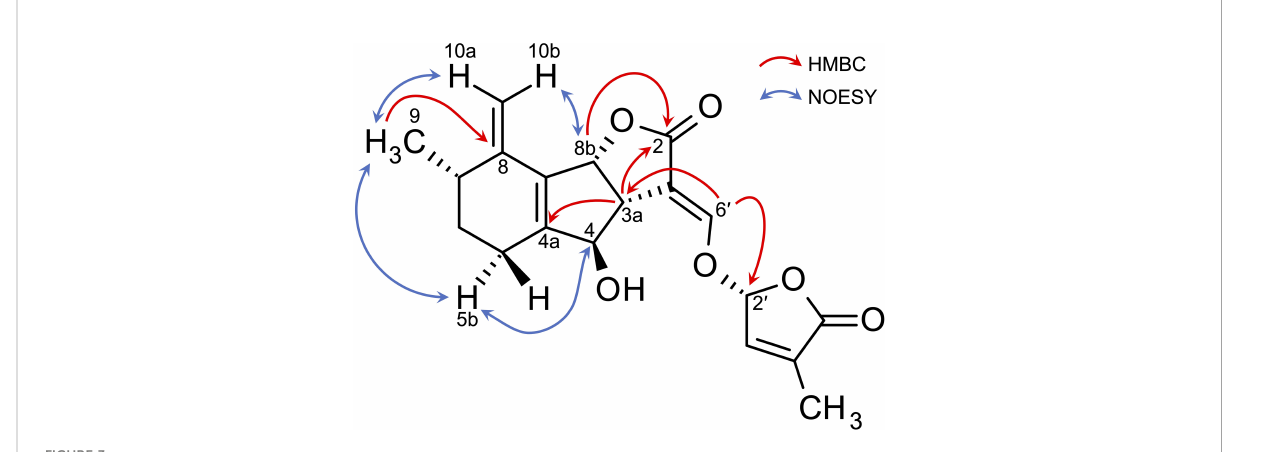
FIGURE 3 Key HMBC and NOESY correlations of